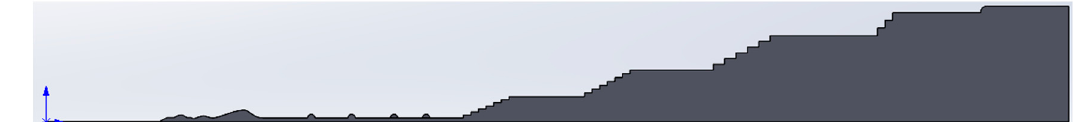
Figure 6. Obstacle crossing experiment terrain.